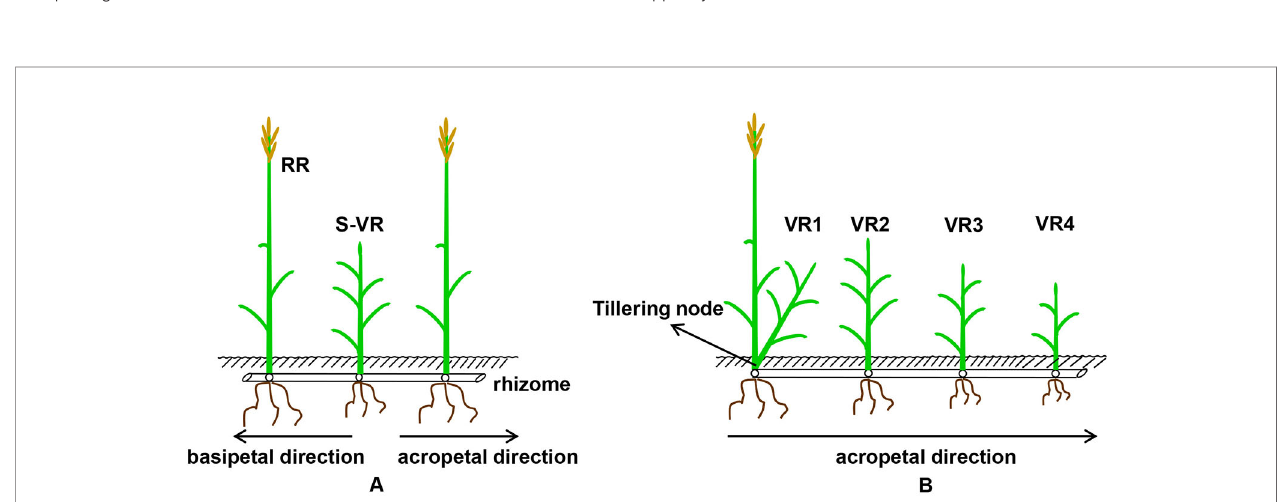
FIGURE 1 | A diagrammatic drawing of spacer vegetative ramets ( A , three-member-clonal system of two reproductive ramets and one spacer vegetative ramet connected by one and the same rhizome) and acropetal vegetative ramets of different position order ( B , fi ve-member-clonal system of one basipetal reproductive ramet and four vegetative ramets connected via one and the same rhizome) labeled with 15 N isotope (RR, reproductive ramet; S, spacer; VR, vegetative ramets; digital 1, 2, 3, 4, position order of acropetal vegetative ramet, VR1 is on the tillering node, VR2, VR3, and VR4 are all on the